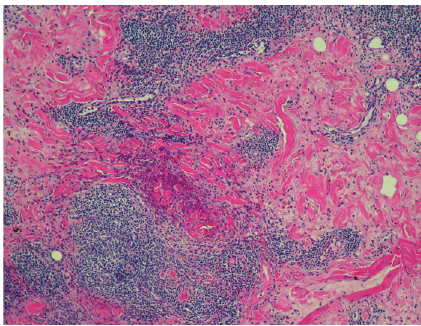
Figure 5: Histology.